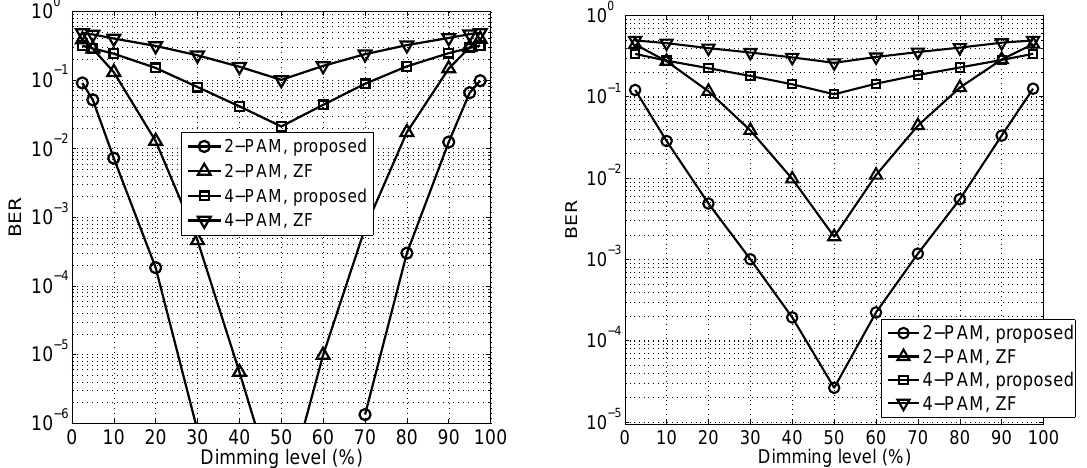
Figure 4. BER of the multiuser VLC system using PAM (left: Scenario 1, right: Scenario 2). ZF, zero-forcing.